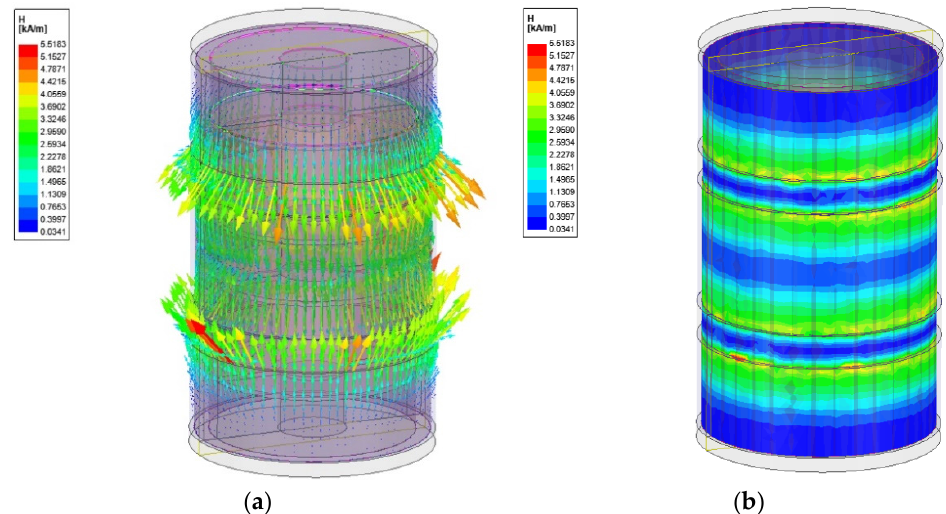
Figure 8. Magnetic field analysis result of the designed tactile device; ( a ) vector expressions of mag- netic intensity at the effective surface in the cross-section, ( b ) magnitude contour expressions of magnetic intensity at the effective surface in the cross-section.